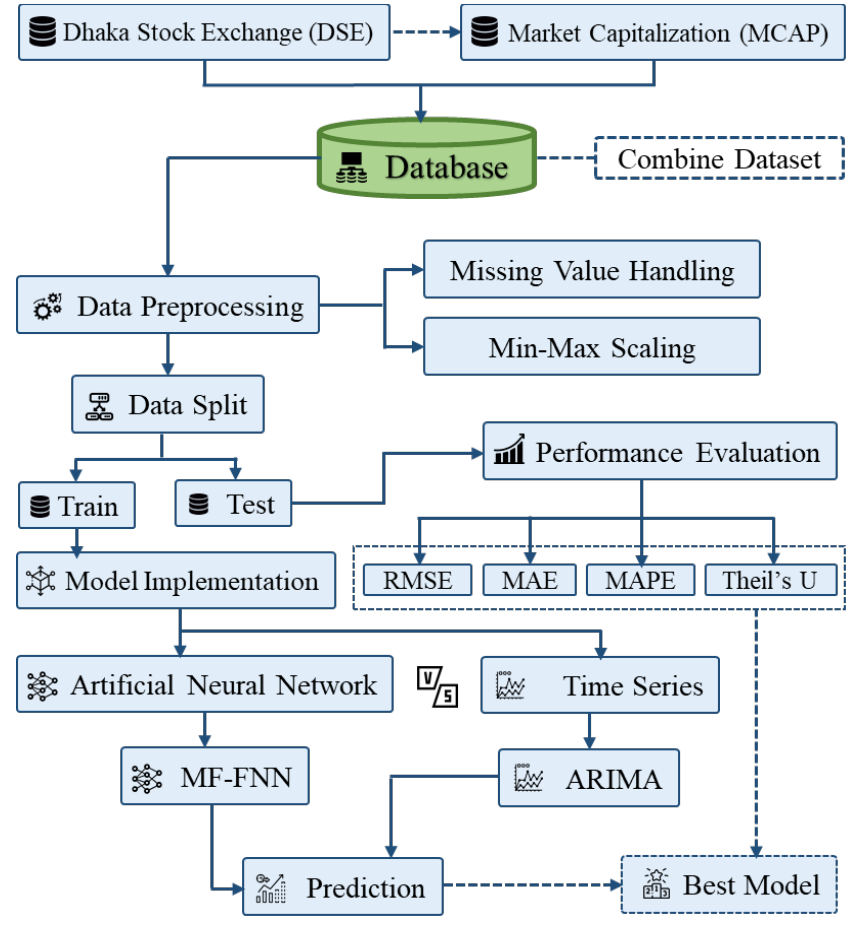
Figure 1. Working procedure diagram to the prediction of Dhaka stock price using ANN and ARIMA